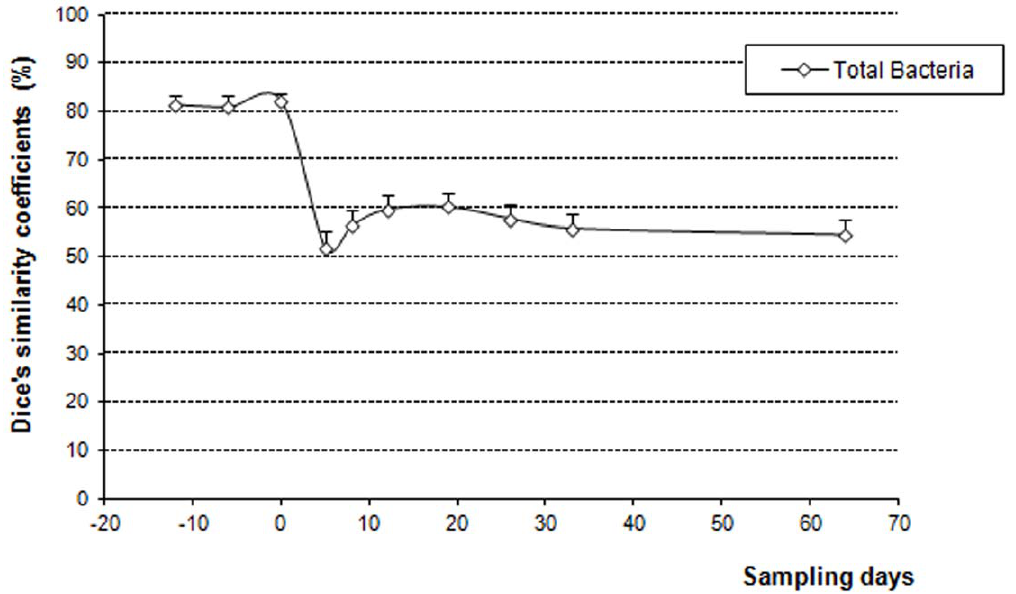
Figure 2. Mean similarity coefficients of TTGE profiles of samples collected before and after AMC exposure (day0–day5) and calculated according to the reference period (day-12 day-6 day 0; n=18).